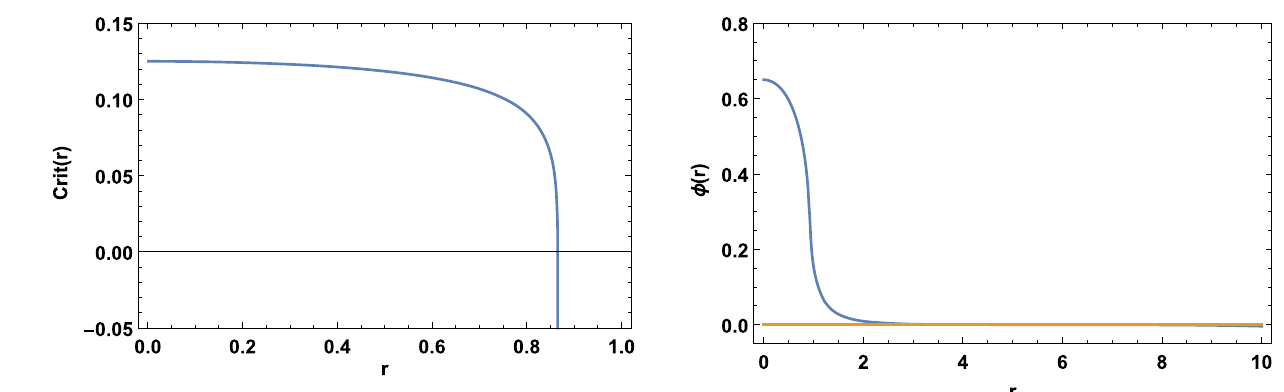
Fig. 7 The scalar field in this case also shows the bell-like behaviour as a function of radius, which again tends to the Yukawa potential form at large distances